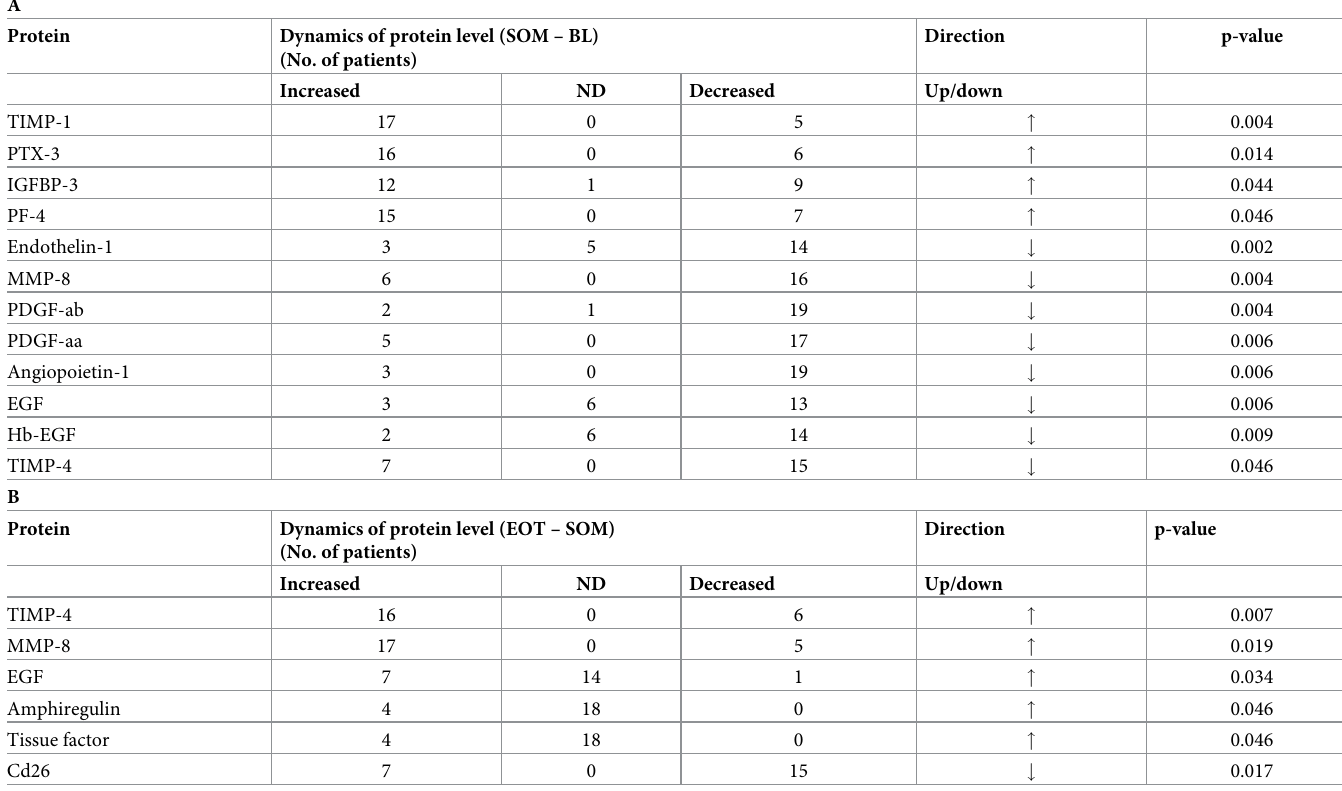
Table 3. Proteins with nominal evidence for change (unadjusted p < 0.05) during treatment of the protein array cohort (n=22 patients). A Dynamics of protein level (SOM – BL) (No. of